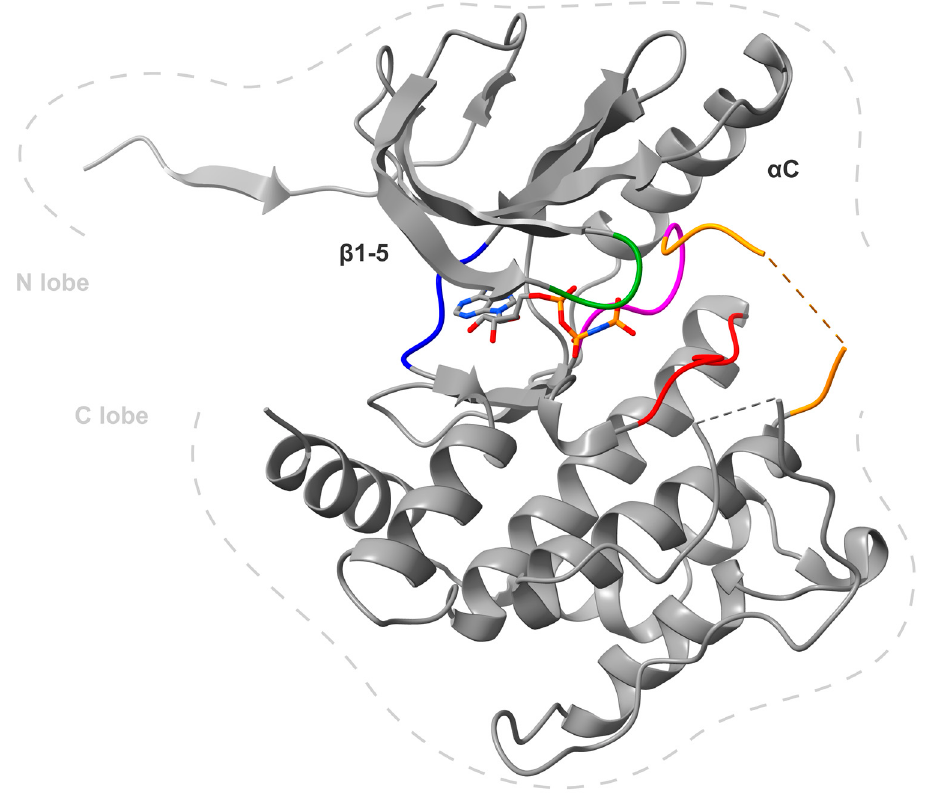
Figure 1. X-ray crystal structure of MKK4 monomer A in a complex with adenylyl-imidodiphosphate (PDB: 3aln) [17]. The general structure of protein kinases is clearly visible, with the N-terminal domain at the top (N lobe) dominated by β -sheets and the C-terminal domain at the bottom (C lobe), composed mainly of α -helices. Important structures are colored: hinge region (blue), glycine-rich loop (green), Mg 2+ -binding loop with DFG motif (magenta), catalytic loop with HRD motif (red) and the disordered activation loop, which contains the activation helix but is not shown due to presumably high flexibility (orange). Disordered secondary structures are shown in dashed lines in the protein. Image generated using ChimeraX [54].